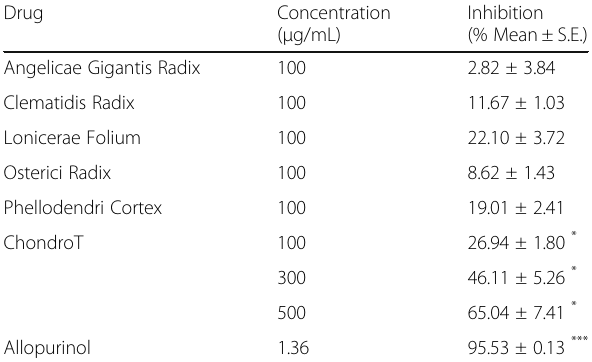
Table 3 Effects of ChondroT on in vitro xanthine oxidase (XOD) activity